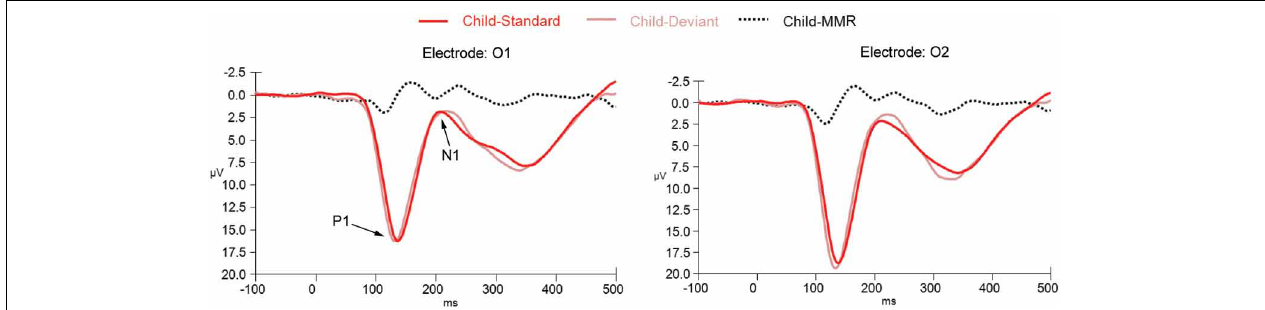
FIGURE 4 | ERPs for deviant non-target and standard non-target stimulus conditions as well as the difference wave computed by subtracting standard non-target from deviant non-target ERPs in children ( N = 21) at electrode positions O1 and O2.